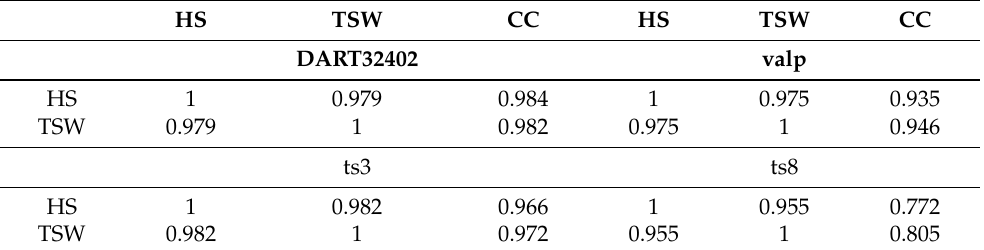
Table 6. Correlation coefficients of Experiment 1730 for the first two hours of the time series, also shown in Figure S5 of the Supplementary Materials. Abbreviations used are the following—HS: Tsunami- HySEA; TSW: TsunAWI; CC: COMCOT. Refer to Figure 1 for the tide gauge and DART locations.